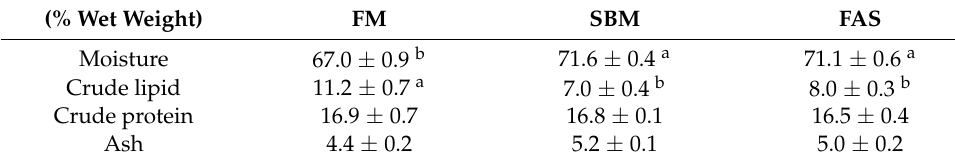
Table 2. The body composition in Japanese sea bass fed functional